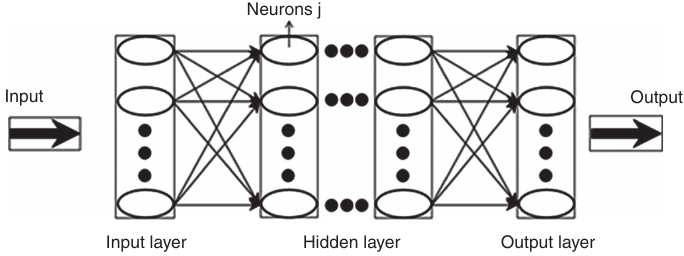
Figure 3 A typical multilayered ANN